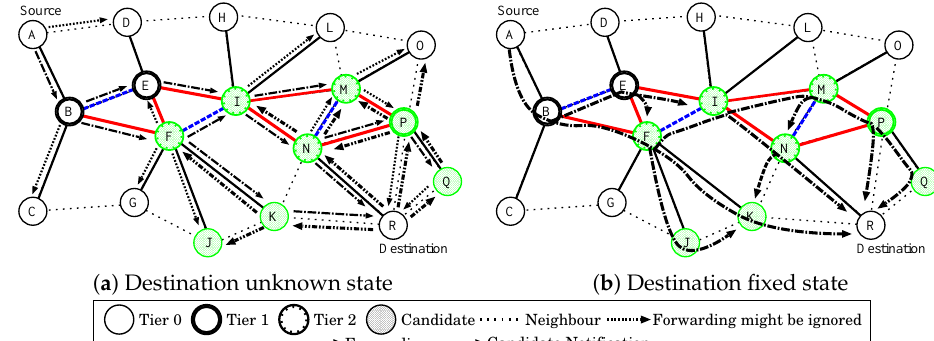
Figure 2. Forwarding in